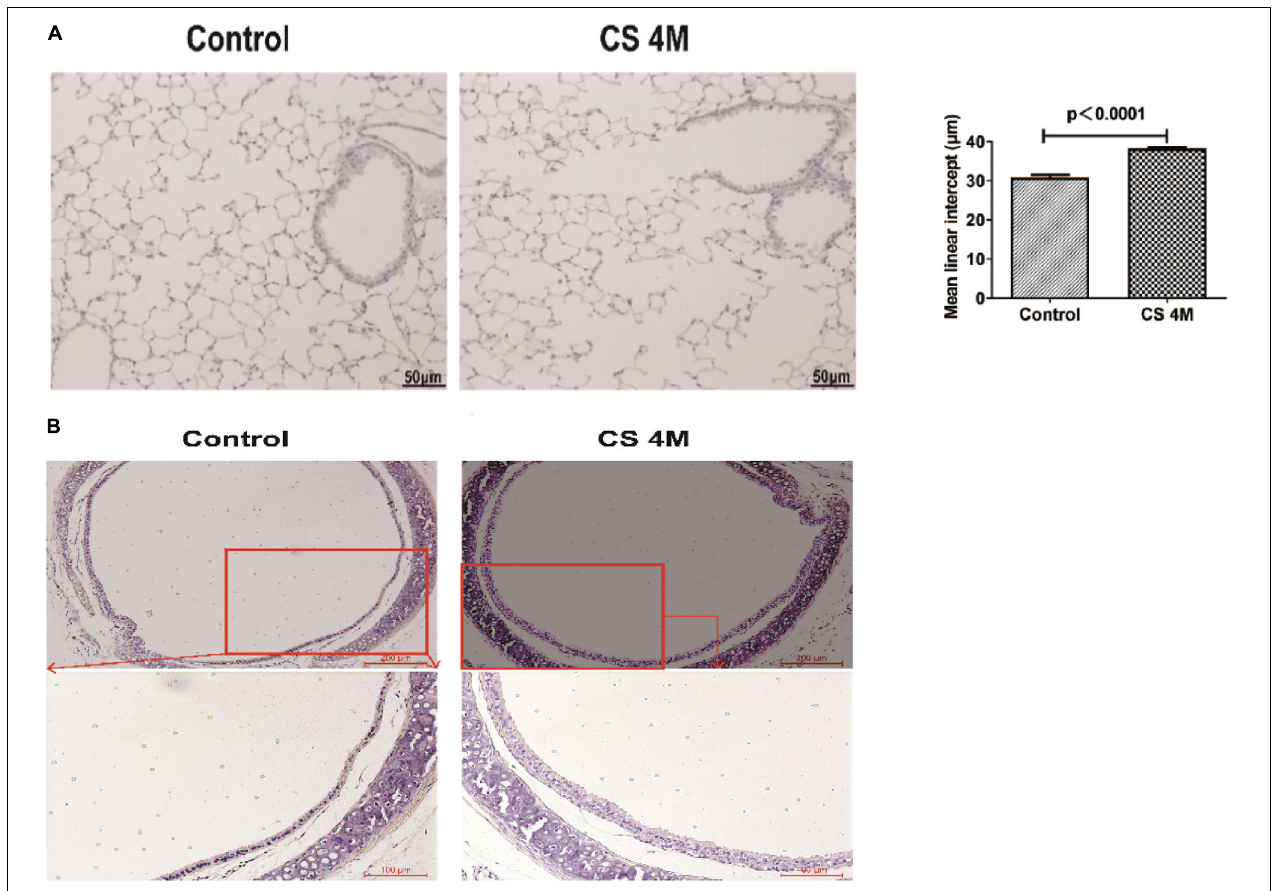
FIGURE 2 | The H&E staining of the airway and lung section of mice after chronic CS exposure for 16 weeks. (A) H&E staining of the lung section of mice in the control group and the CS4M group after chronic CS exposure for 16 weeks ( n = 4, bar = 50 µ m, CS4M = cigarette smoke exposure for 16 weeks). Mean linear intercept of alveoli of mice in the control group and the CS4M group after chronic cigarette smoke exposure for 16 weeks. (B) H&E staining of the airway section of mice in the control group and the CS4M group after chronic CS exposure for 16 weeks ( n = 4, the up panel bar is 200 µ m, the bottom panel bar is 100 µ